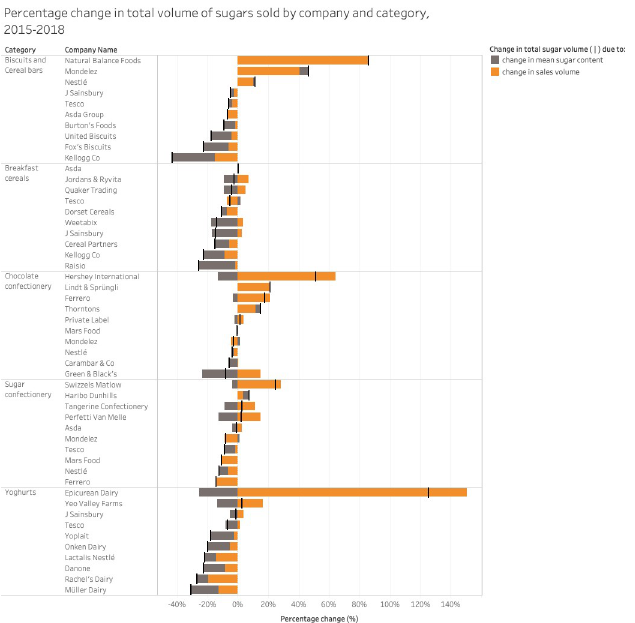
Fig 3. AU : PleasecheckthattheeditstothetitleofFig 3 captureyourmeaning : Ifnot ; pleaseeditasnecessary : Percentage change in the total volume of sugar sold by the top 10 companies in each category between 2015 and 2018. Black marker lines represent the percentage change of total volume of sugars sold by company and category. This total change is split into the percentage change due to changes in volume sales of products (orange) and the percentage change due to changes in the mean sugar content of products (grey).